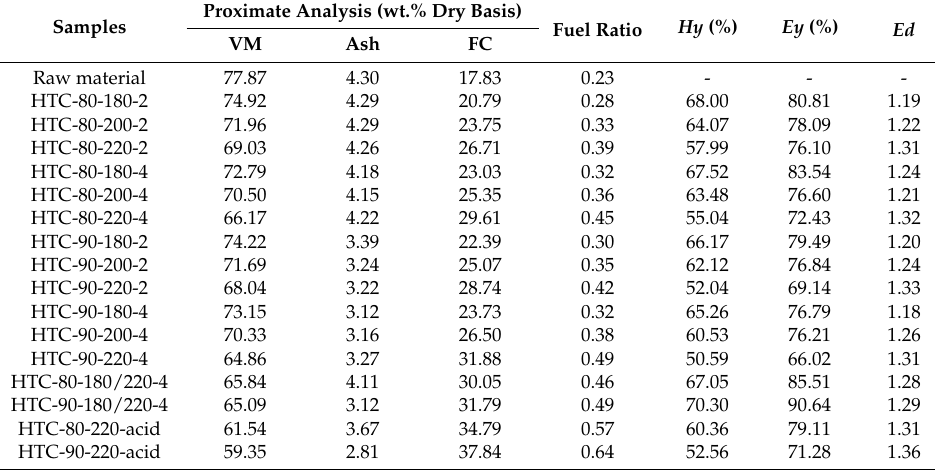
Table 2. Proximate analysis and fuel (see methods for